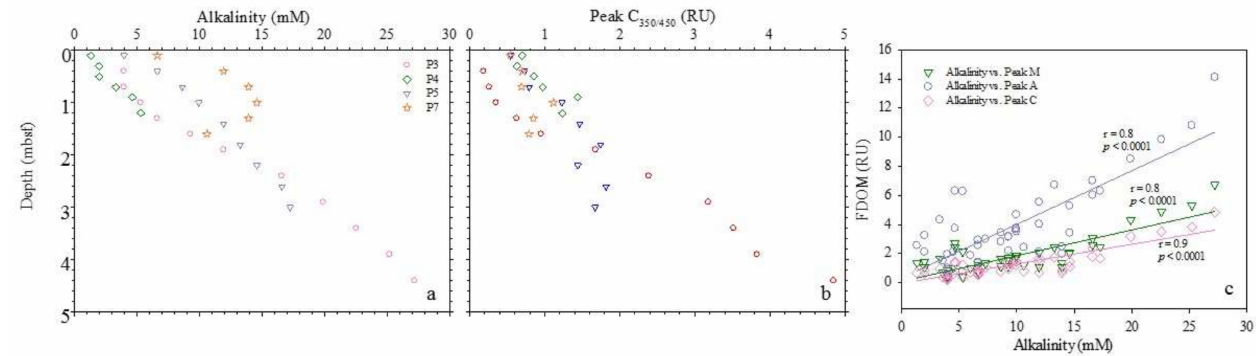
Figure 7. Examples of the increasing down core profiles of alkalinity and the humic-like fluorescent DOM (FDOM) ( a , b ) and positive linear correlations between the humic-like FDOM vs. alkalinity ( c ) for the sediment pore waters from the West Svalbard fjords of the high Arctic. Table 1. Net increase (positive) or decrease (negative) or DOM from surface sediment to depth in the high Arctic.